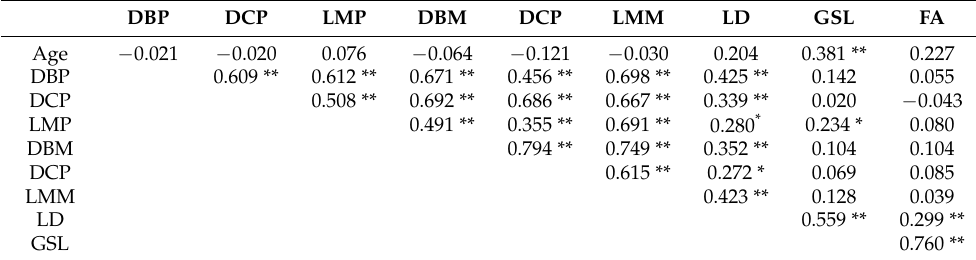
Table 5. Coefficients of correlation between measurements of digital bones and between these measurements and horse age.